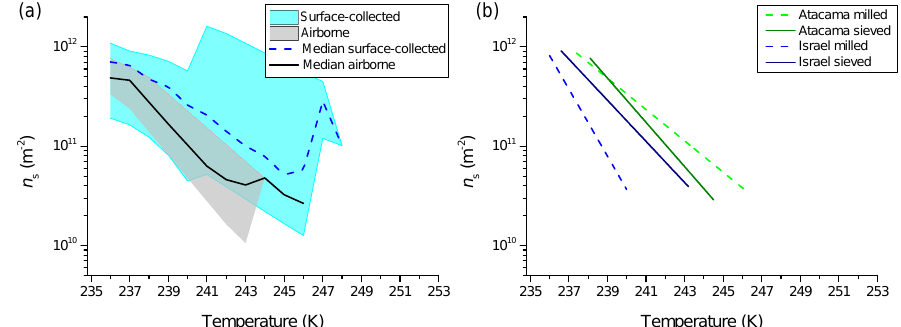
Figure 6. (a) Median and minimum to maximum n s range of airborne and surface-collected samples. (b) Comparison of ice-active surface site density of milled and sieved